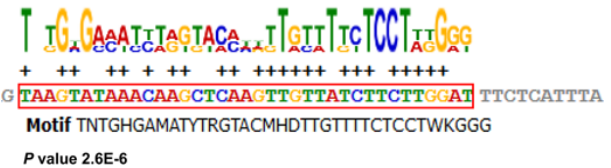
Figure 5. Bioinformatics predicts transcription factor binding sites on the 4bp indel sequences. One potential transcriptional factor FOXC1 (Forkhead box C1) appears only at insertion sequence. Red highlights the FOXC1 factor binding site